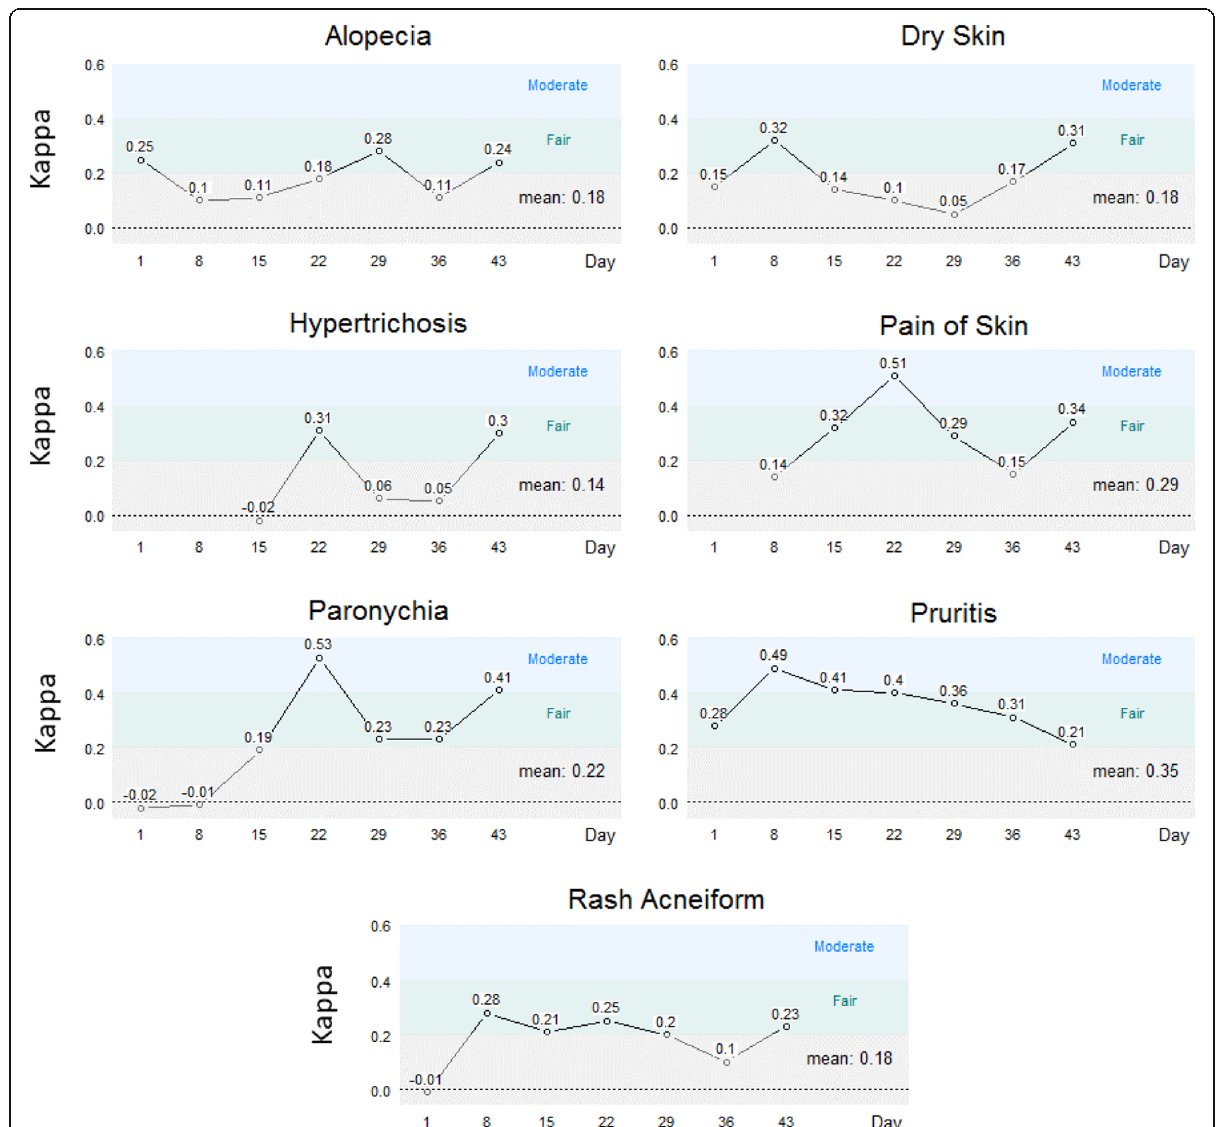
Fig. 2 Criterion Validity For Each Symptom Based on Kappa Statistics Overall (Mean) and by Assessment Day. Criterion validity for the seven treatment toxicity categories most commonly associated with EGFRI toxicity. Criterion validity is based on agreement between the FACT-EGFRI 18 and the CTCAE scoring systems, and was assessed both overall and by assessment day. Moderate or better agreement is defined as Kappa coefficients of ≥